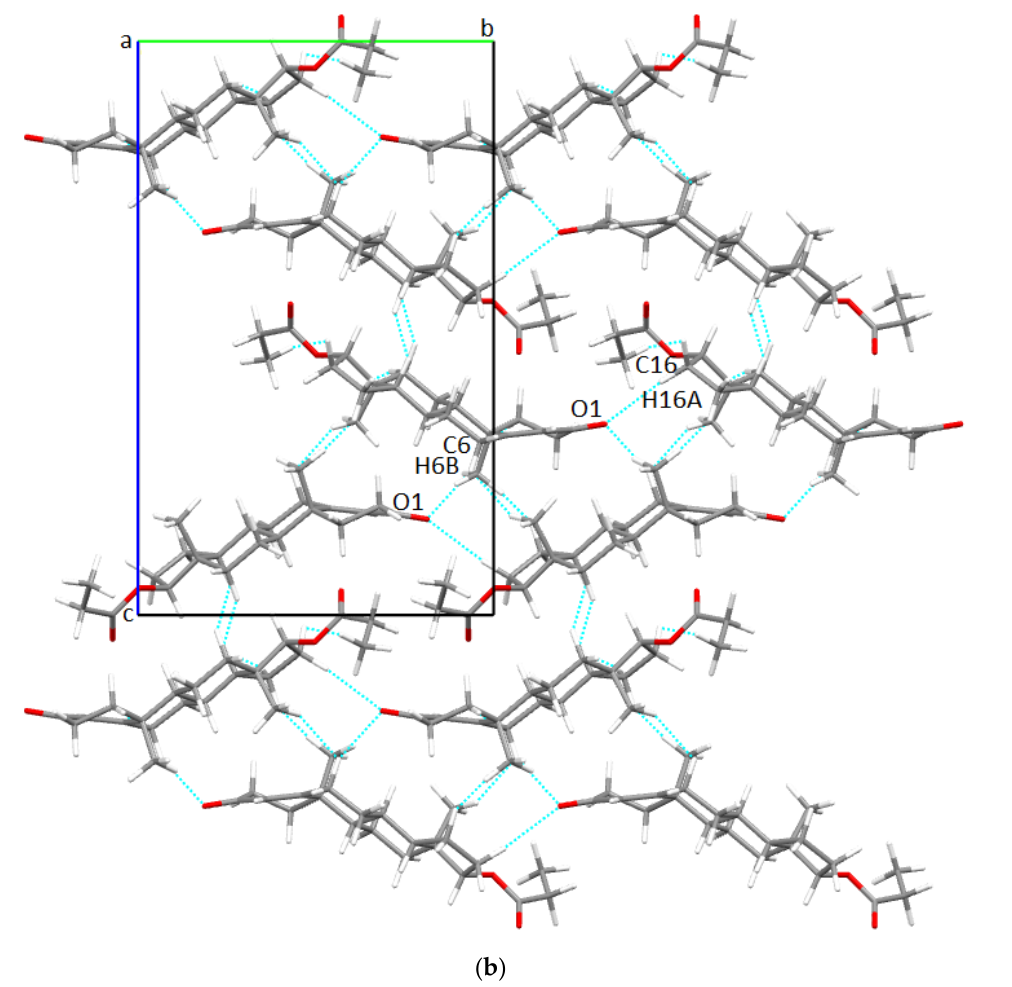
Figure 2. Asymmetric unit of TPro presenting nonhydrogen atoms at 50% probability level ( a ) and overall packing diagram along a-axis ( b ).